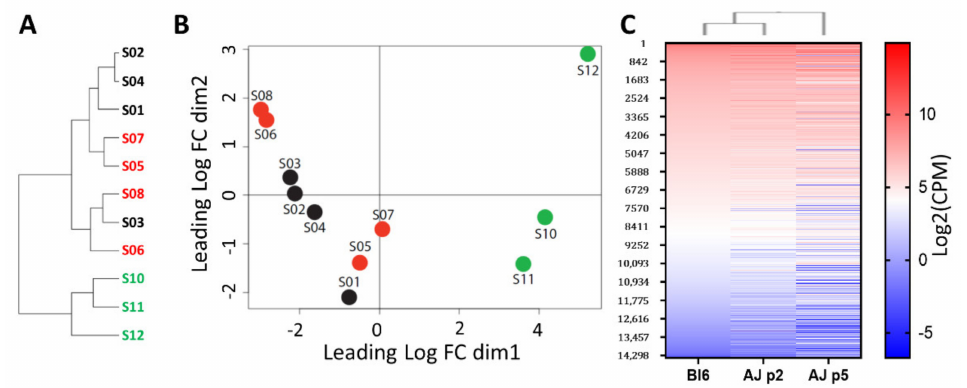
Figure 2. Relative distance between low and high-stemness ANPG organoids samples . ( A ) Tree recapitulating relative distance between samples. Low-propagating ANPG: S01 to S04 represent C57Bl/6 passage 2 quadruplicates, S05 to S08 represent A/J passage 2 quadruplicates. High- propagating ANPGs: S10 to S12 represent A/J passage 5 triplicate. ( B ) Multidimensional scanning plot based on the fold changes between samples. Distances between 2 points approximate the ex- pression differences between the corresponding RNA samples. ( C ) Heatmap showing relative gene expression level in low-stemness ANPG from C57Bl/6 passage 2 (lane 1) and A/J passage 2 (lane 2) and high-stemness A/J passage 5 ANPG (lane 3). The data shows relatively similar transcriptomic signature between C57BL/6 and A/J ANPG at passage 2, whereas a more distant pattern of gene expression is observed in A/J at passage 5